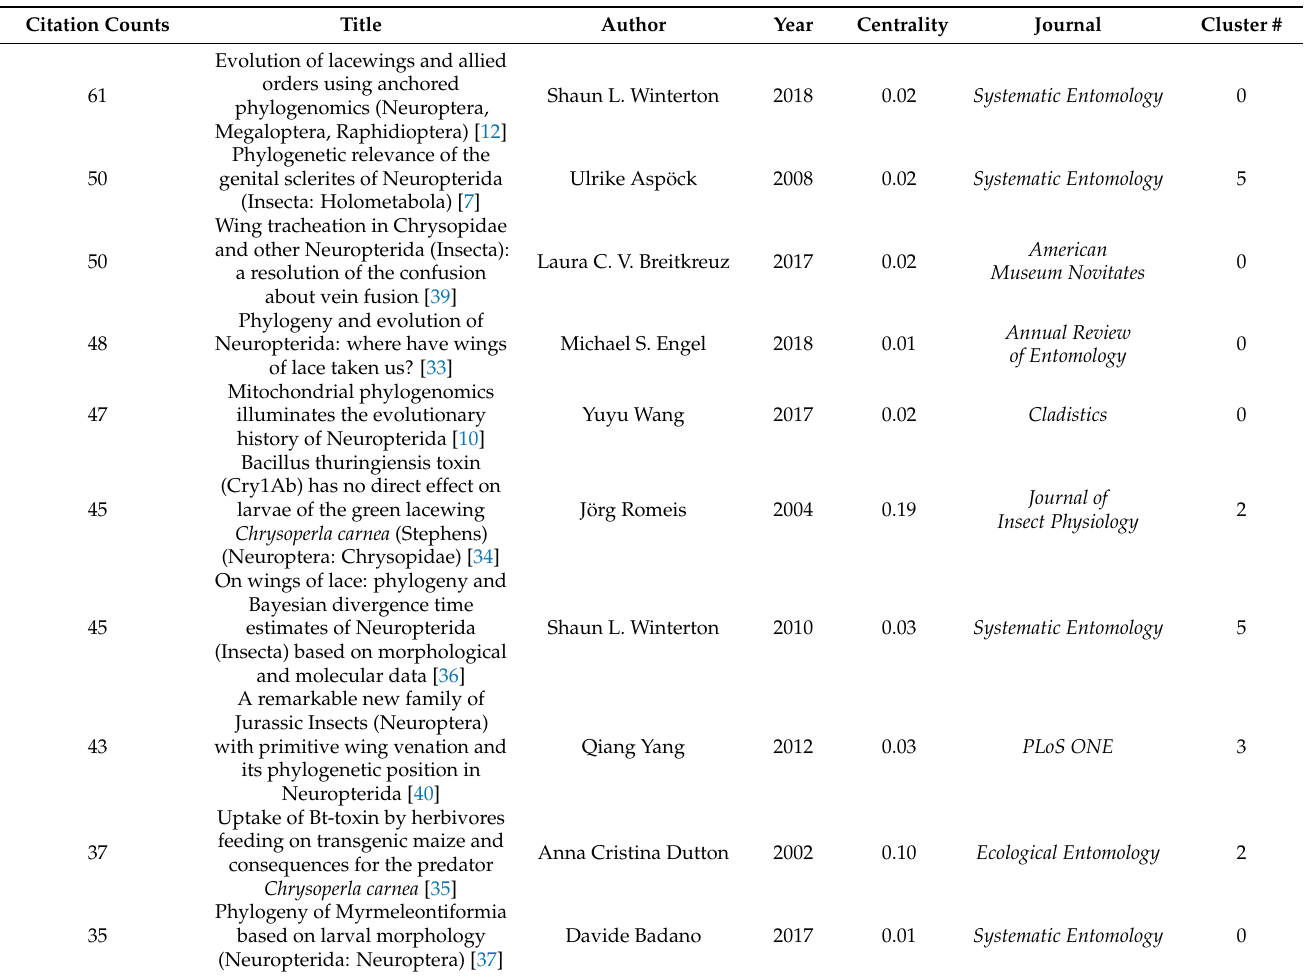
Table 1. Top 10 most cited articles about Neuropterida.